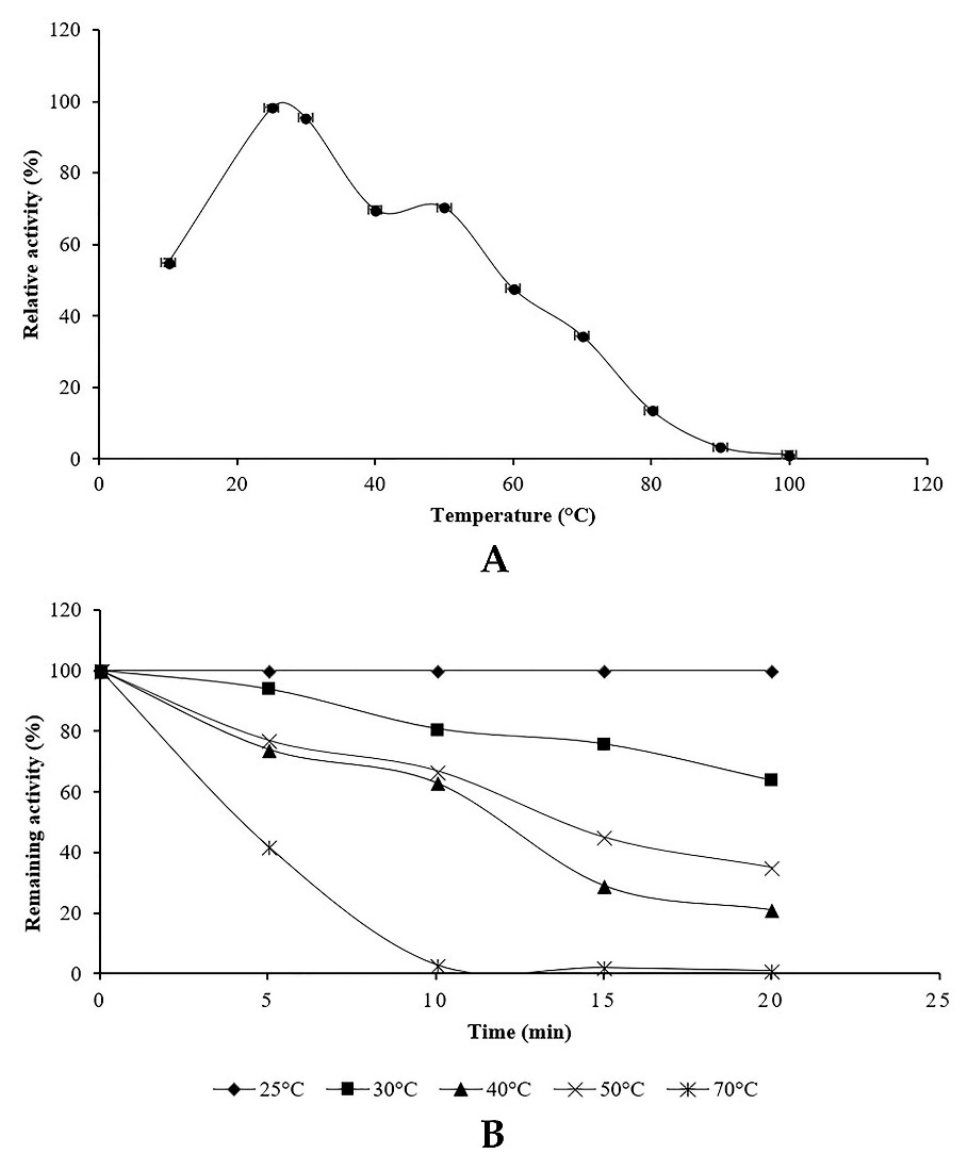
Figure 5. Effect of temperature on the activity ( A ) and the stability ( B ) of proteolytic enzyme of Penicillium bilaiae .